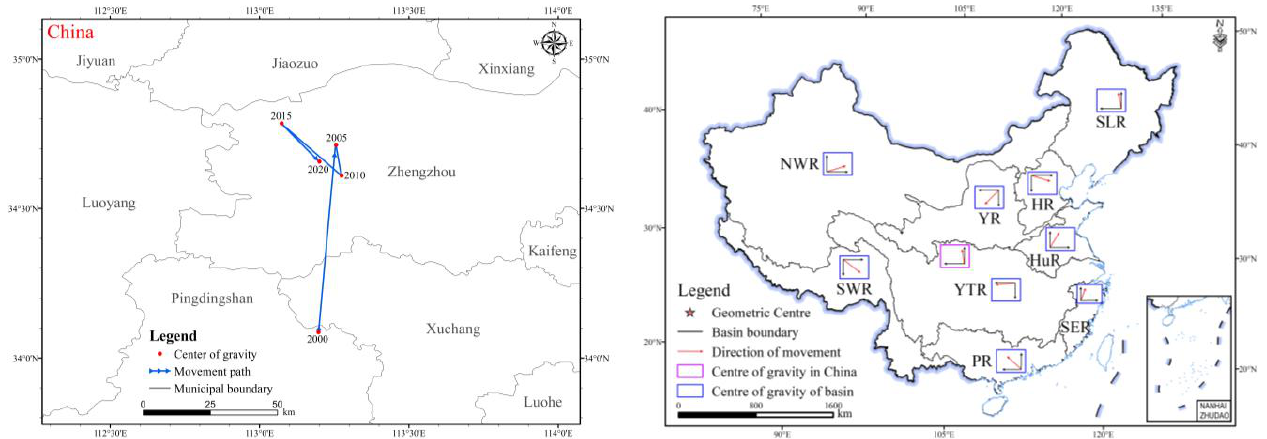
Figure 9. The movement trajectory of the center of gravity of artificial water bodies in China and various river basins from 2000 to 2020 and the direction of movement.